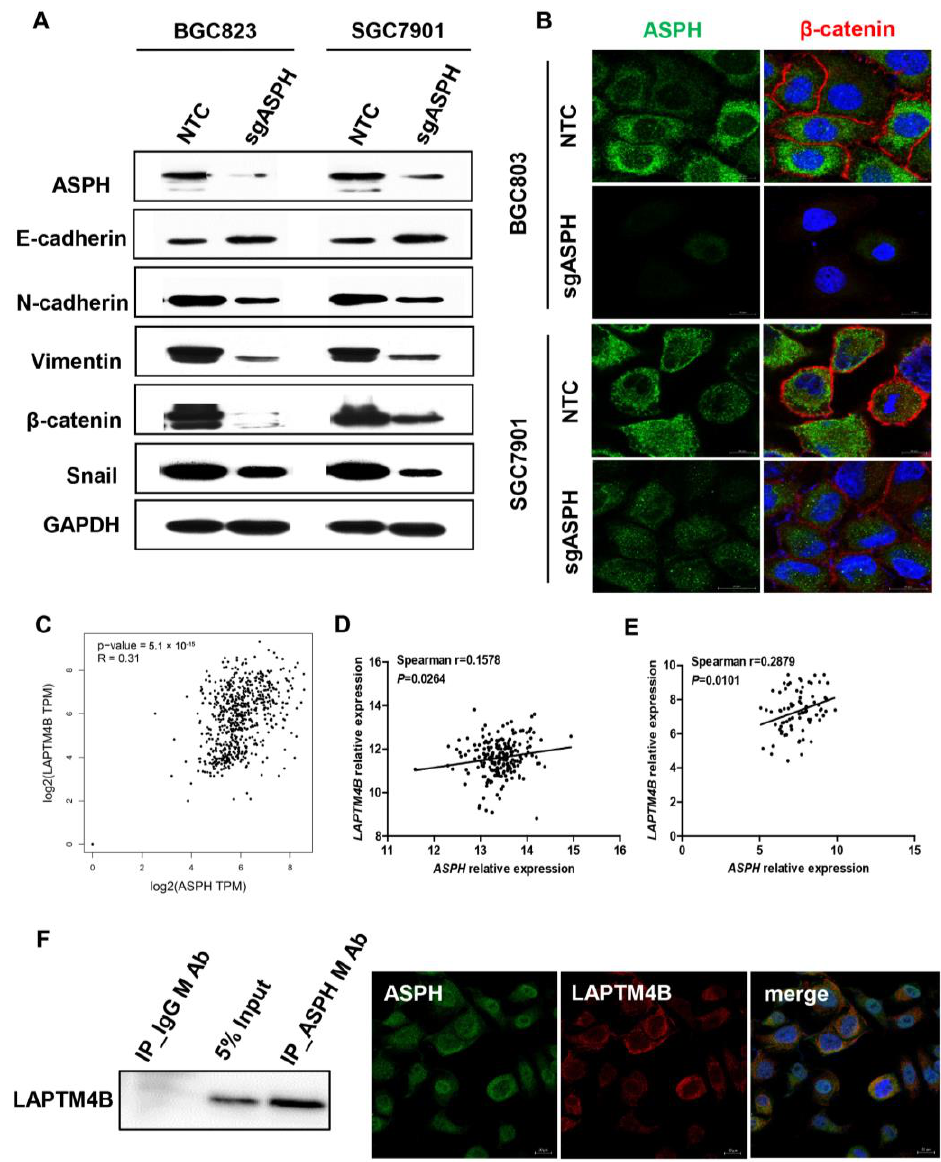
Figure 4. ASPH regulates the EMT process and interacts with LAPTM4B. ( A ) EMT markers (E- cadherin, N-cadherin, vimentin, β -catenin and Snail) were detected by Western blot in BGC823 and SGC7901 cells. ( B ) The expression of β -catenin correlates with ASPH levels verified by immunoflu- orescence staining. ASPH (green), β -catenin (red) and DAPI (blue). Scale bar: 10 μm . ( C – E ) Correla- tion analysis between ASPH mRNA and LAPT4B mRNA expression (TCGA-STAD, ( C ); GES13861, ( D ) and GES63089, ( E )). ( F ) Co-immunoprecipitation and immunofluorescent demonstration of ASPH physically interacts with LAPTM4B. ASPH (green), LAPTM4B (red) and DAPI (blue). Scale bar: 10 μm . 3. Discussion Several previous studies suggested that ASPH is highly expressed in various tumor types including GC, and ASPH overexpression predicts a worse prognosis [8,13,16]. Intri- guingly, within our clinical GC cohort, the expression level of ASPH is strongly associated with the prognosis of patients who accepted pre-operation NACT, while this correlation is not observed in patients without NACT. For patients with resectable GC, perioperative chemotherapy that includes NACT is one standard treatment option, which is a multimo- dality therapy that results in recovery in about ~50% of patients [20,21]. Patients with